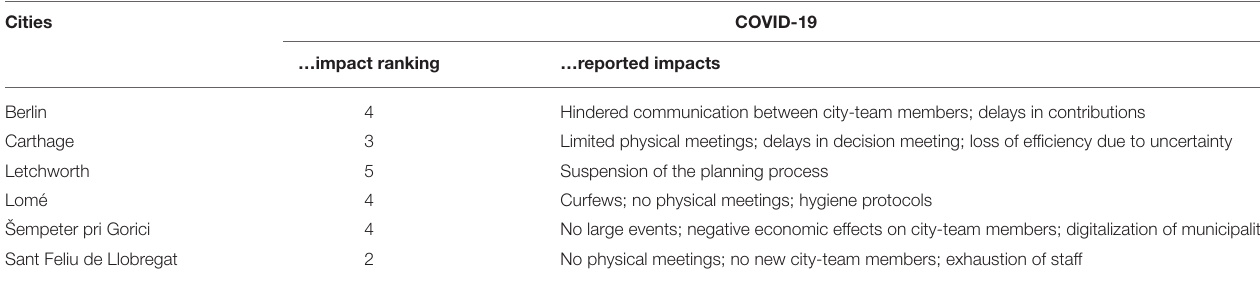
TABLE 4 | Assessment of the severity of COVID-19 impacts (ranked by city coordination or hub during the survey 1 = low; 5 = high) and most relevant COVID-19 impacts on city-team members. Cities COVID-19 …impact ranking …reported impacts 4 Carthage